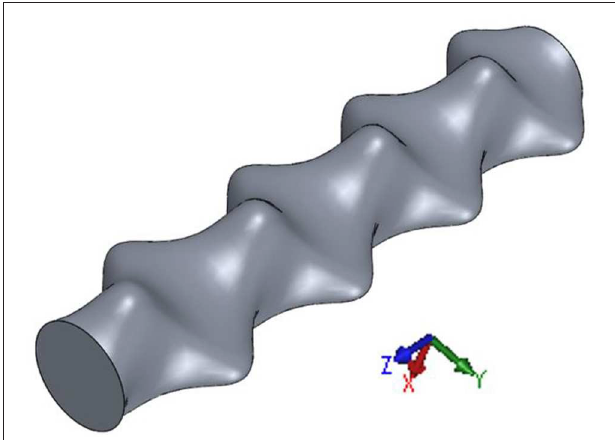
FIGURE 4 | Isometric view of a double corrugated tube generated in CAD software using Equation (6).